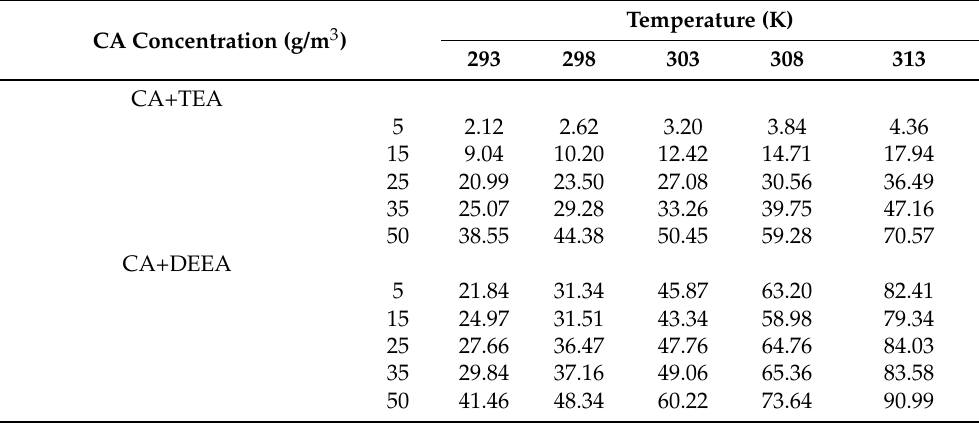
Table A3. Experimental kinetics data of k 0, with CA of CO Containing various amounts of CA over a temperature range of 293–313